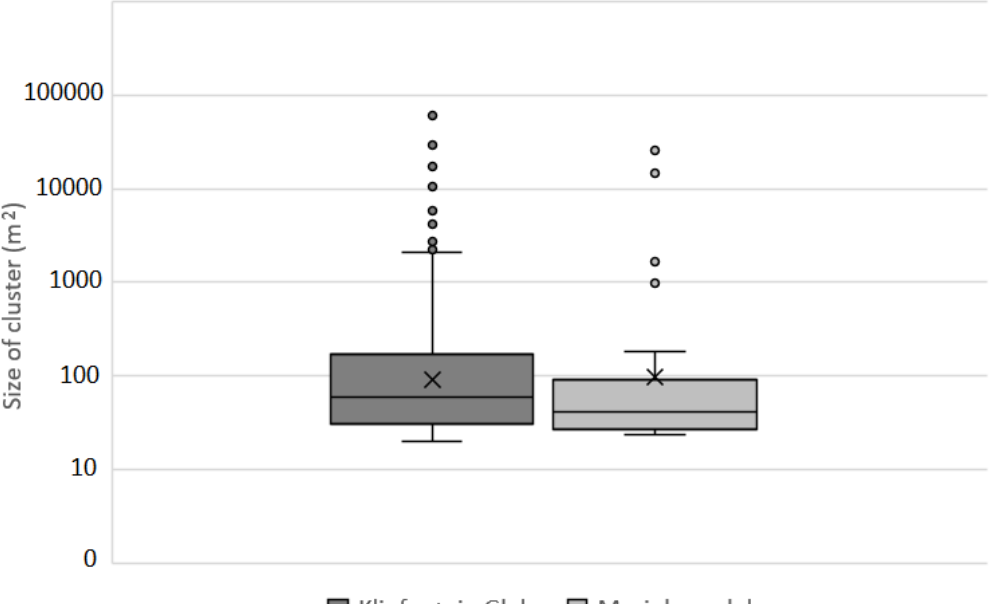
Figure 7. Box and whisker chart of size of clusters in Klipfontein Glebe and Masiphumelele. Note the log scale on the